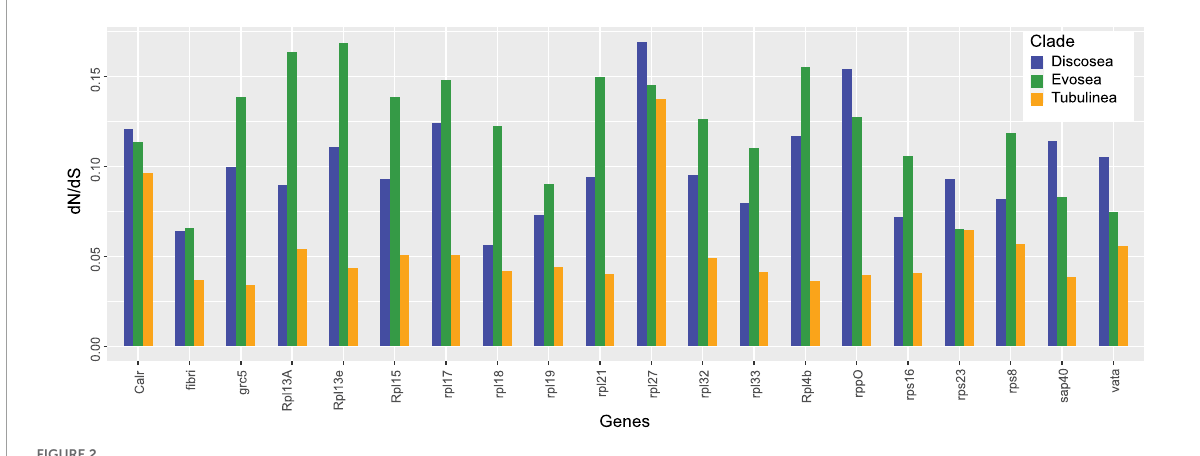
FIGURE2 Estimates of dN/dS in each shared gene among Discosea, Evosea, and